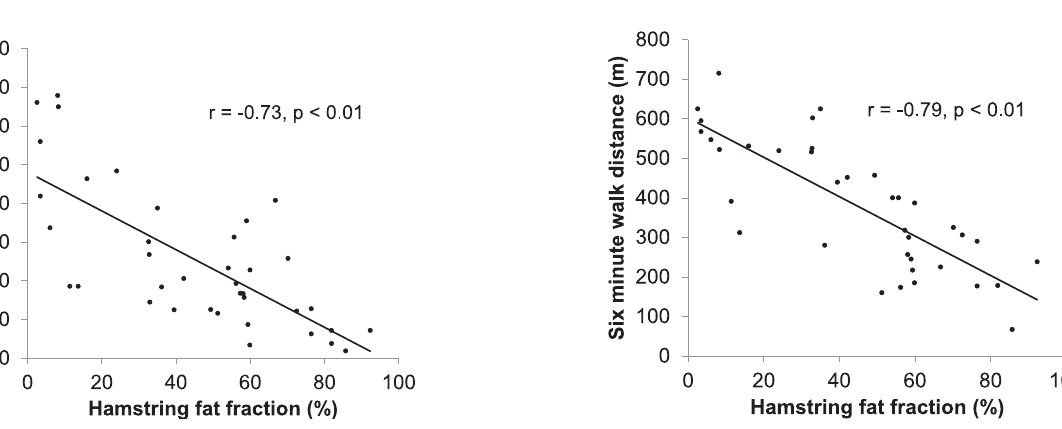
Figure 7. Strong correlation between knee flexion strength (in pounds) and hamstring average fat fraction, r= 2 .73 (p , 0.01).